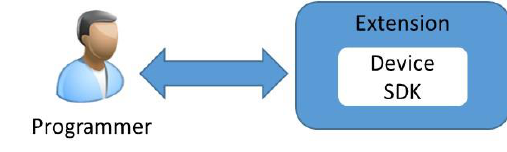
Figure 2. Interaction